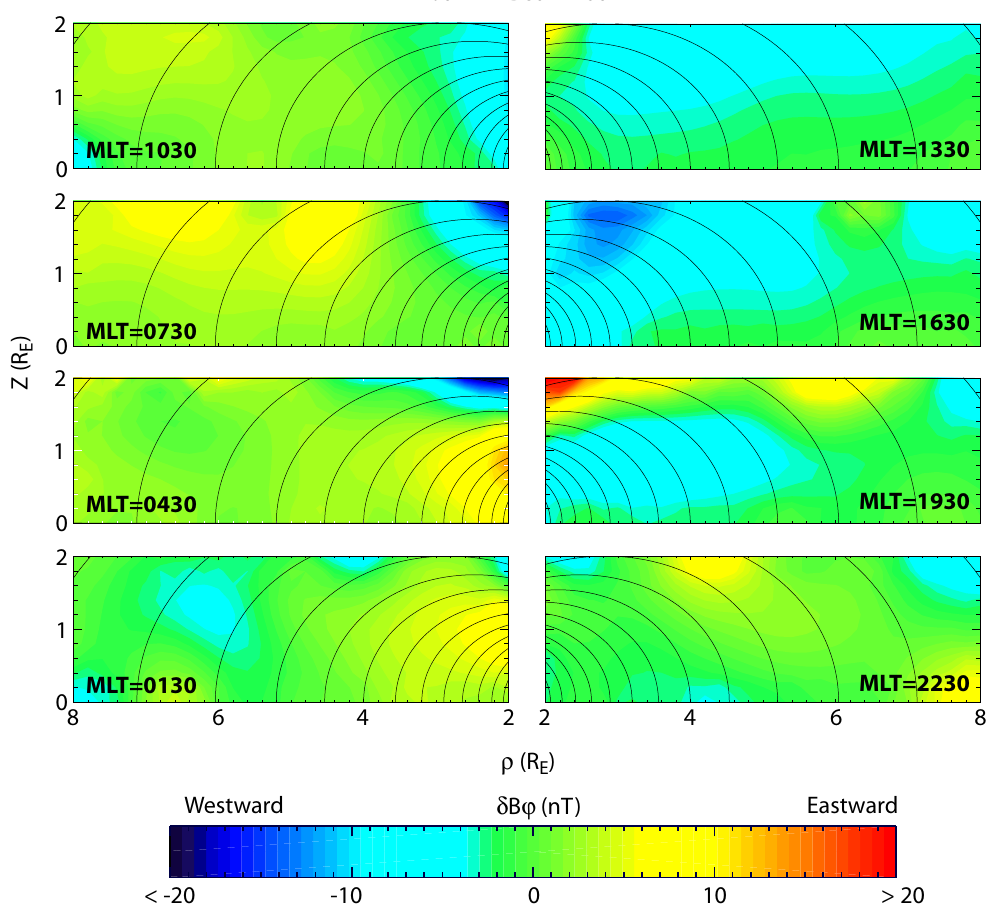
Fig. 5c. Azimuthal component of perturbation magnetic field with superimposed dipole field lines in each of the 8 magnetic local time bins and for each of the four D st * ranges. Only the northern meridian plane is shown. The southern part is anti-symmetric to the northern part: (c) − 60nT >D st * > −